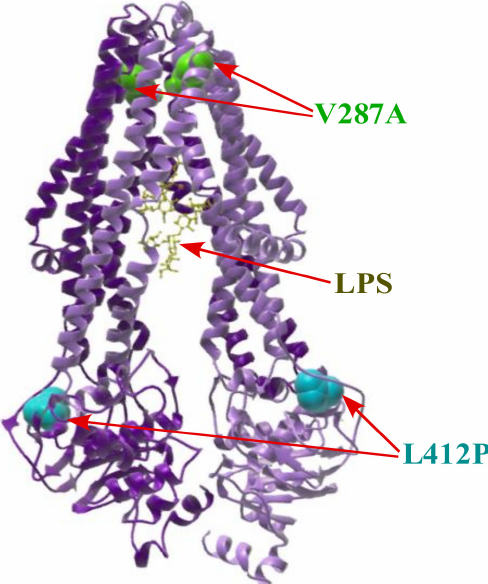
Figure 9. Mutations mapping to the msbA gene can bypass the synthetic lethality of ∆ ( lpxL lapD ) and ∆ ( lpxM lapD ) bacteria. Positions of various single amino acid substitutions in the structure of MsbA (PDB 6BPL) [30] are shown by arrows. The position of the LPS is also indicated and marked by the